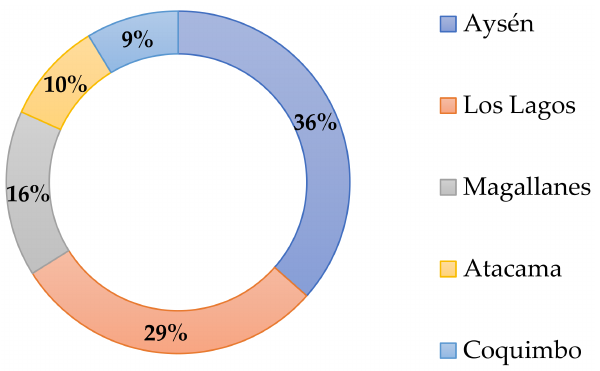
Figure 12. Regional distribution of Pseudo-nitzschia HABs events in